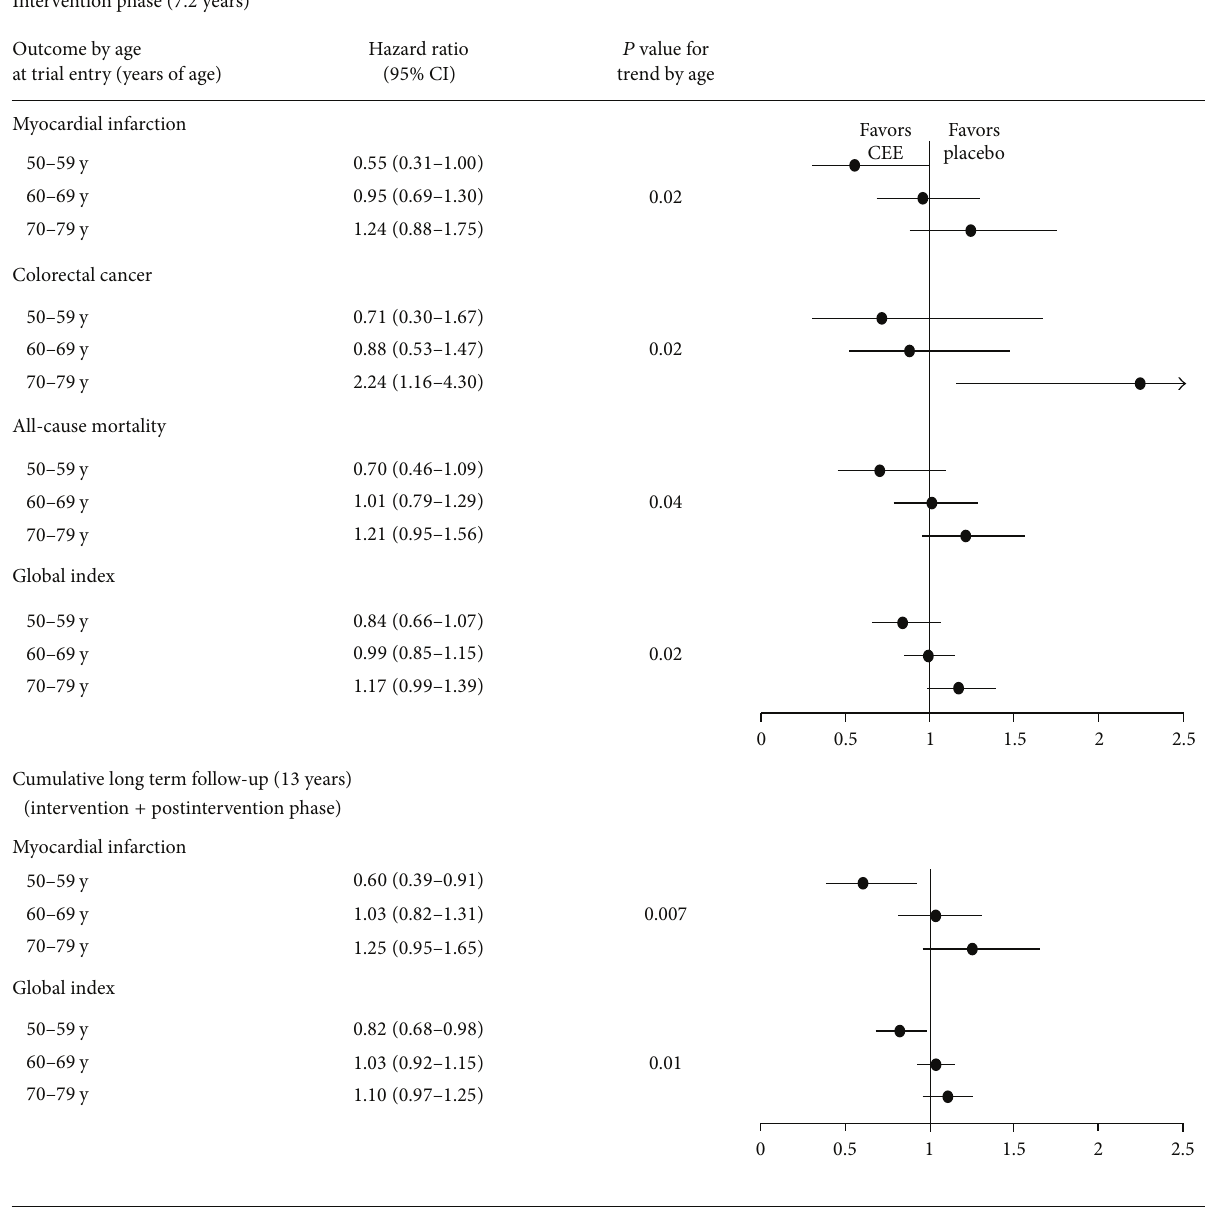
Figure 1: Primary and secondary trial outcomes with a significant trend by age ( P for interaction) in Women’s Health Initiative Estrogen- Alone Trial. CEE: conjugated equine estrogens; y: years of age. Source for outcomes: